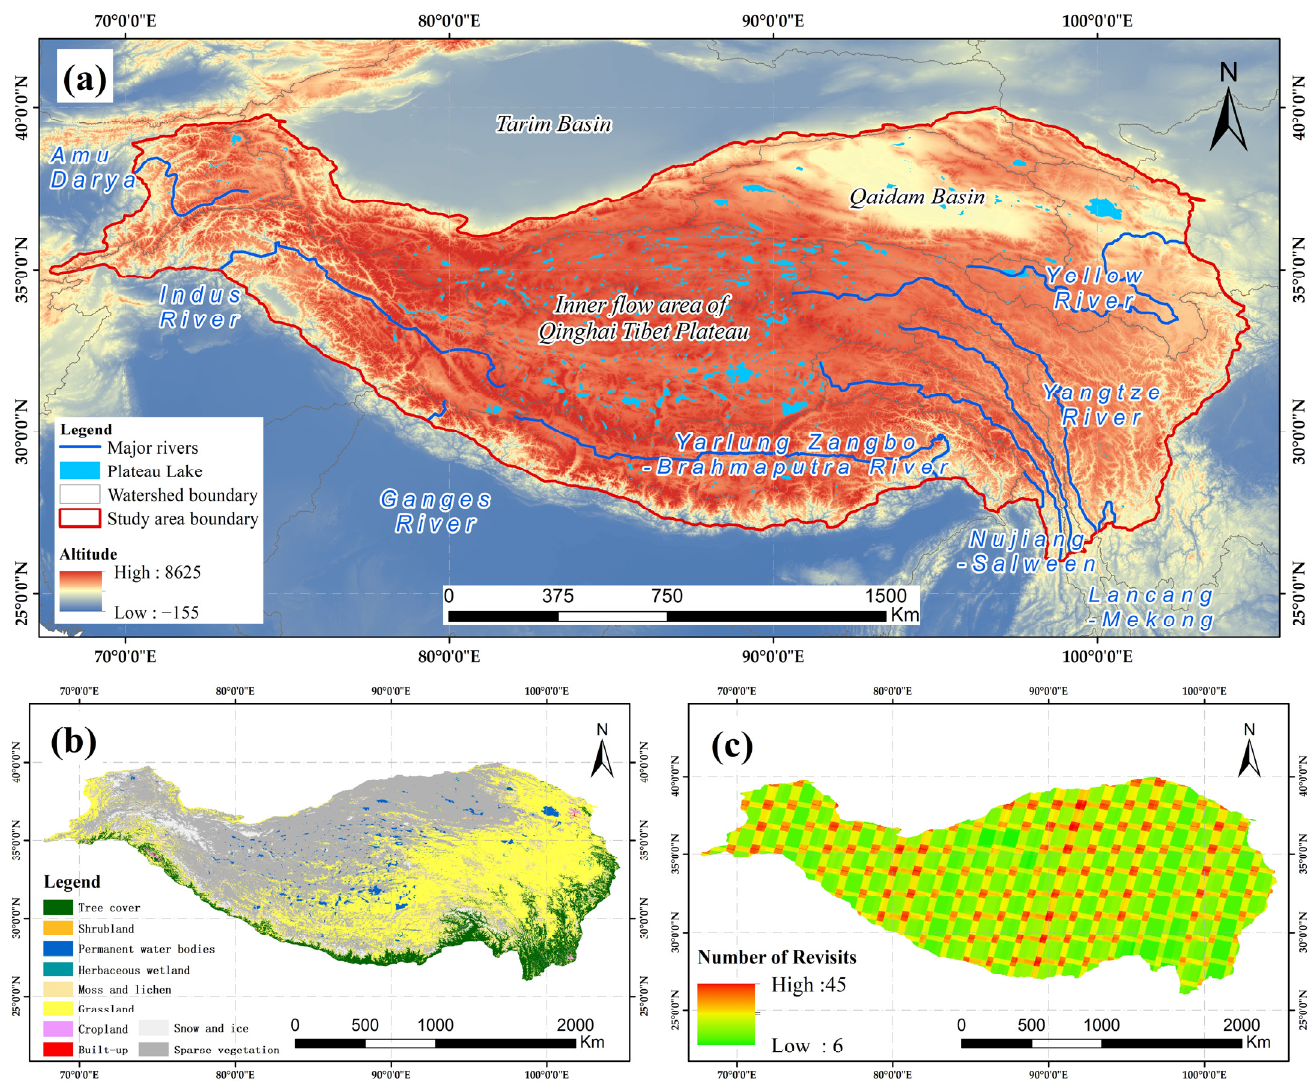
Figure 1. Study region and dataset. ( a ) Locations of the study area and the terrain characterized. Study area boundary data were mainly based on TPBoundary_2021. The primary river data were collected from HydroRIVERS. The lake data were based on TPLA_V3. The topographic data were produced by NASA-provided SRTM DEM [61]; ( b ) the landcover data source was ESA_WorldCover; ( c ) the coverage of Landsat-9 images in the study area was based on L9C2_SR. The Qinghai–Tibet Plateau Lake area data set (V3.0) (TPLA_V3,